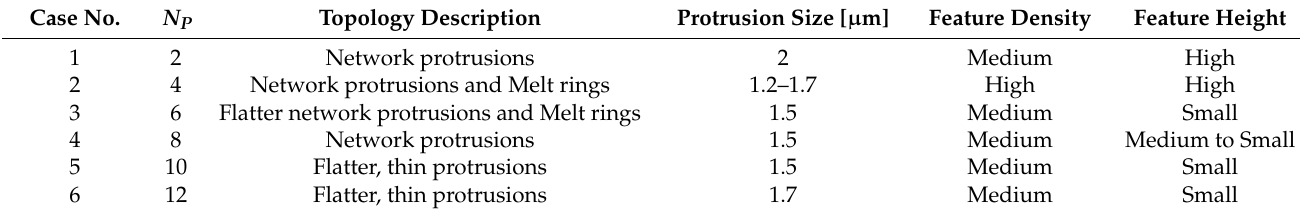
Table 3. Topology variation for spot-by-spot laser-interference processing with 5 mm spot size. Case No.